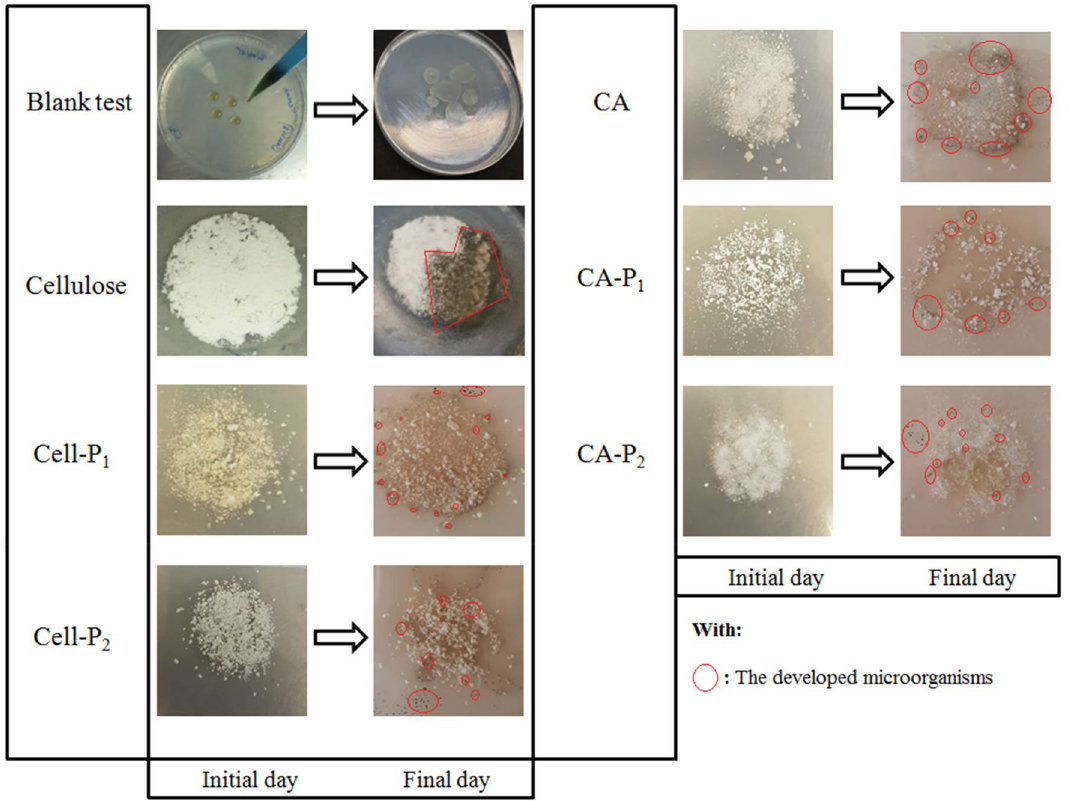
Figure 8. Biodegradation evolution of cellulose, Cell-P 1 , Cell-P 2 , CA, CA-P 1 , and CA-P 2 after 28 days of incubation under aerobic conditions on culture